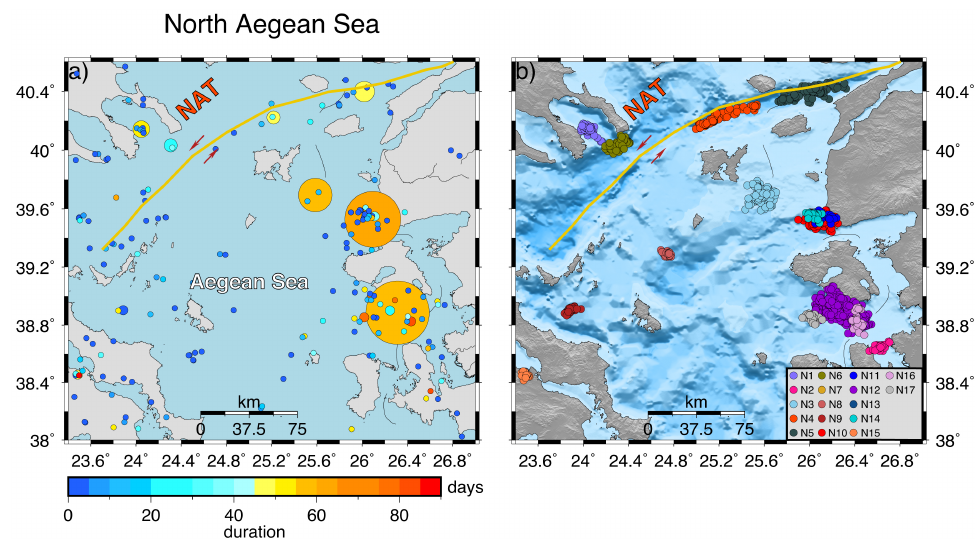
Figure 7. ( a ) Spatial distribution of the centroids of the identified clusters for the area of North Aegean Sea along with the trace of North Aegean Trough (yellow lines). The size of the circles is proportional to the earthquake number in each cluster, whereas the duration is represented by the color scale. ( b ) Spatial distribution of the clusters with N ≥ 30 events. The index of each cluster is given in the inset